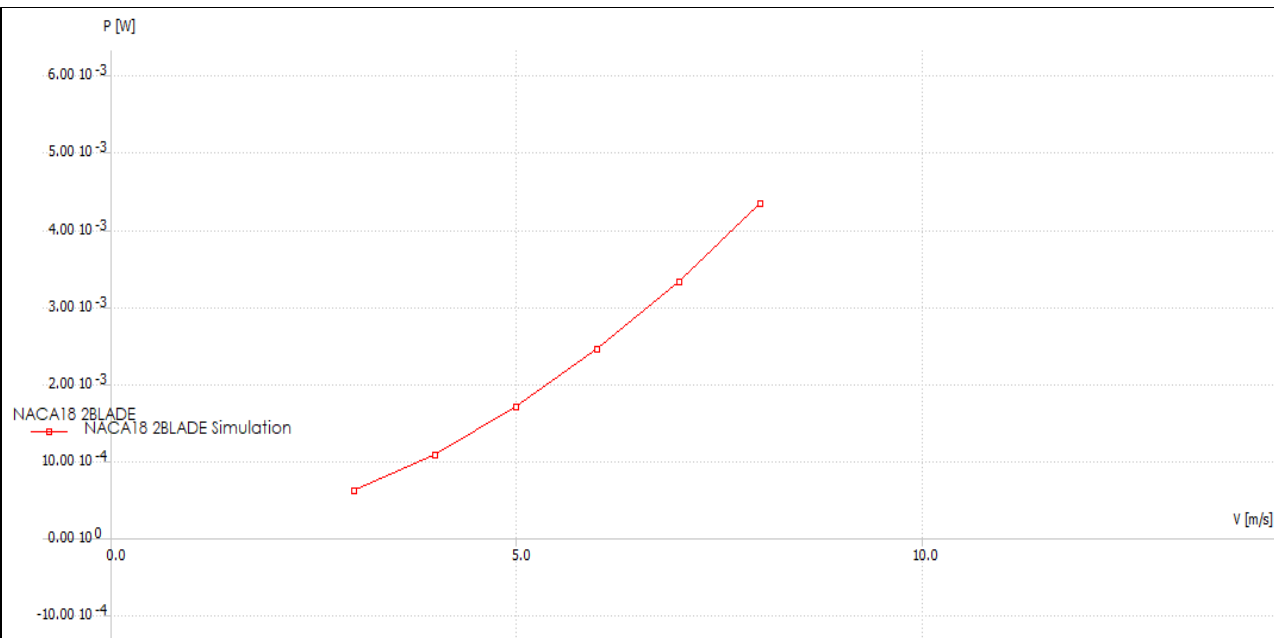
Figure 20. Power vs wind speed for 2 Bladed VAWT